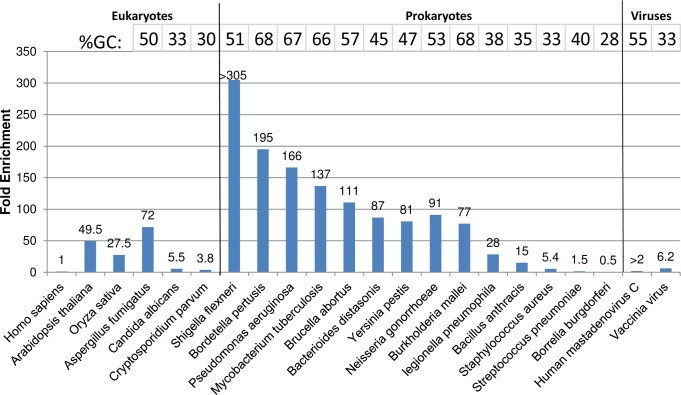
Sequence analysis of HpaII mediated enrichment of a genomic mixture.The fold enrichment (Eq 1) for each Eukaryote, Prokaryote and virus genome is listed. The GC content of microbial genomes are plotted above.